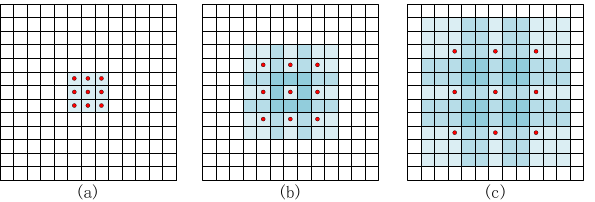
Figure 4. Schematic diagram of different expansion factors. ( a ) The expansion factor is 1 1 ( b ) is the convolution kernel with expansion factor of 2 ( c ) is the convolution kernel with expansion factor of 3. The red dot represents the 3 × 3 convolution kernel. Blue represents the receptive field of hole convolution. Dark colors represent overlapping receptive fields, and light colors represent normal